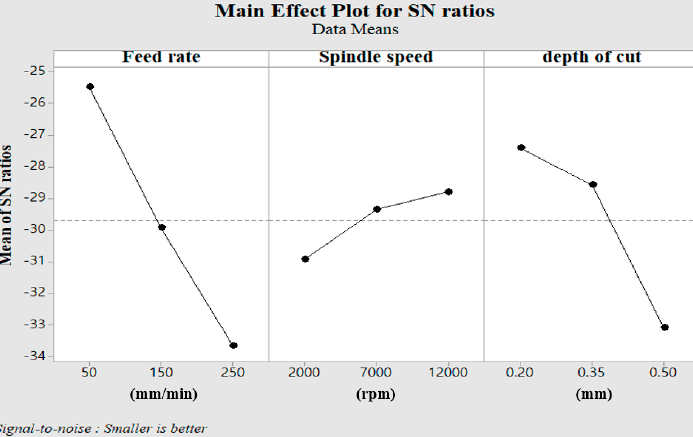
Figure 8. Main effect of the S/N ratio on cutting force. Figure 8. Main e ff ect of the S / N ratio on cutting force. Materials 2019 , 12 , x FOR PEER REVIEW